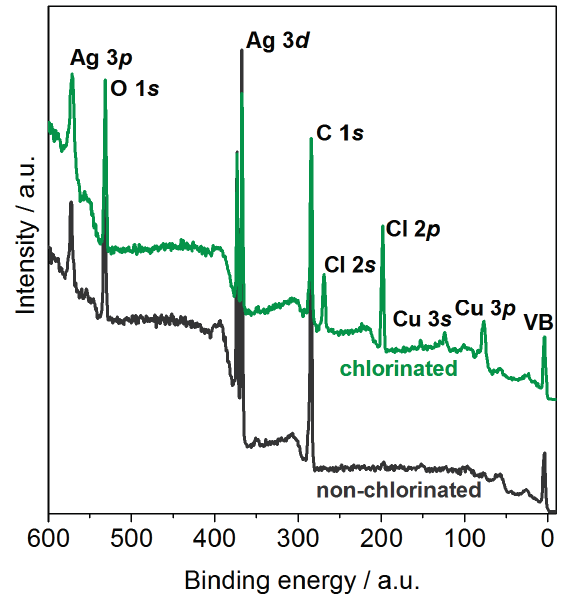
Figure 4. XPS survey spectra of the Ag-coated contacts before and after chlorination. All core lines are